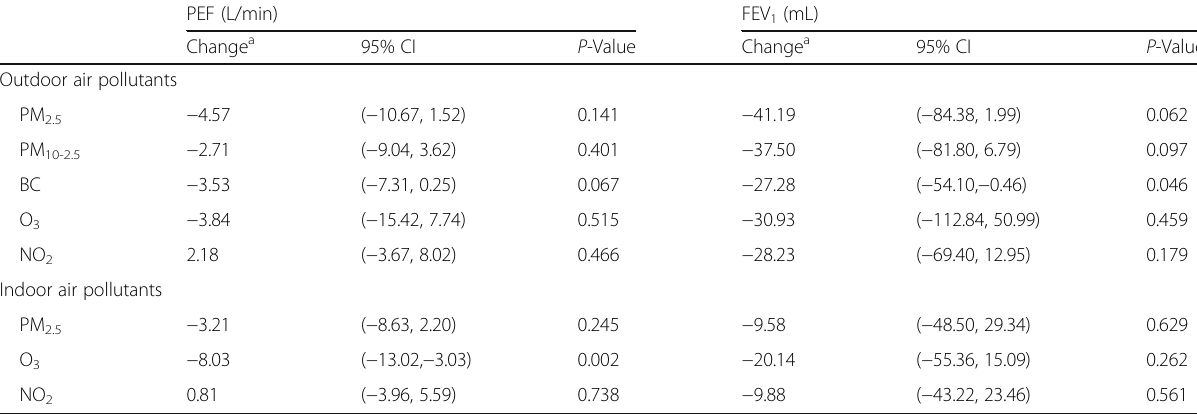
Table 3 Associations between air pollutants and pulmonary function during the study period PEF (L/min) FEV 1 (mL) Change a 95% CI P -Value Change a 95% CI P -Value Outdoor air pollutants PM 2.5 − 4.57 ( − 10.67, 1.52) 0.141 − 41.19 ( − 84.38, 1.99) 0.062 PM 10-2.5 − 2.71 ( − 9.04, 3.62) 0.401 − 37.50 ( − 81.80, 6.79) 0.097 BC − 3.53 ( − 7.31, 0.25) 0.067 − 27.28 ( − 54.10, − 0.46) 0.046 O 3 − 3.84 ( − 15.42, 7.74) 0.515 − 30.93 ( − 112.84, 50.99) 0.459 NO 2 2.18 ( − 3.67, 8.02) 0.466 − 28.23 ( − 69.40, 12.95) 0.179 Indoor air pollutants PM 2.5 − 3.21 ( − 8.63, 2.20) 0.245 − 9.58 ( − 48.50, 29.34) 0.629 O 3 − 8.03 ( − 13.02, − 3.03) 0.002 − 20.14 ( − 55.36, 15.09) 0.262 0.81 ( − 3.96, 5.59) 0.738 − 9.88 ( − 43.22, 23.46) 0.561